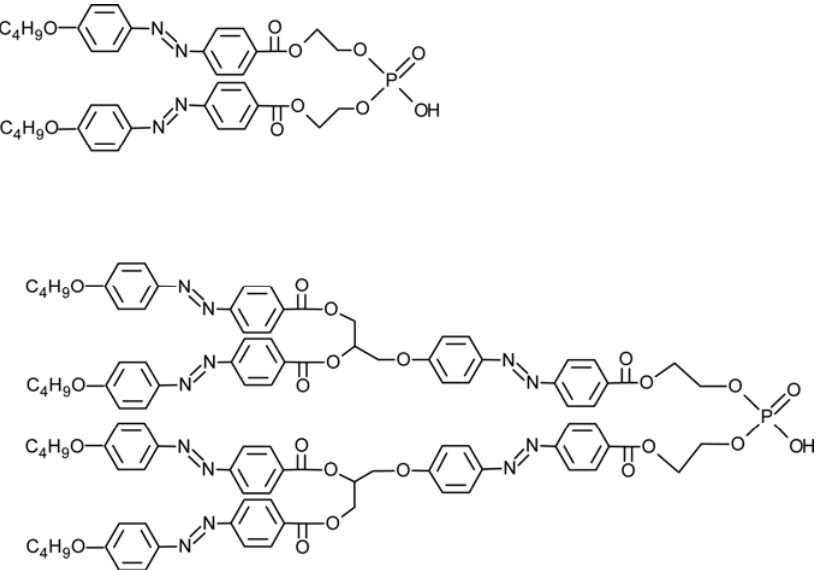
Figure 24. First and second generation of azobenzene-containing dendrimers investigated in